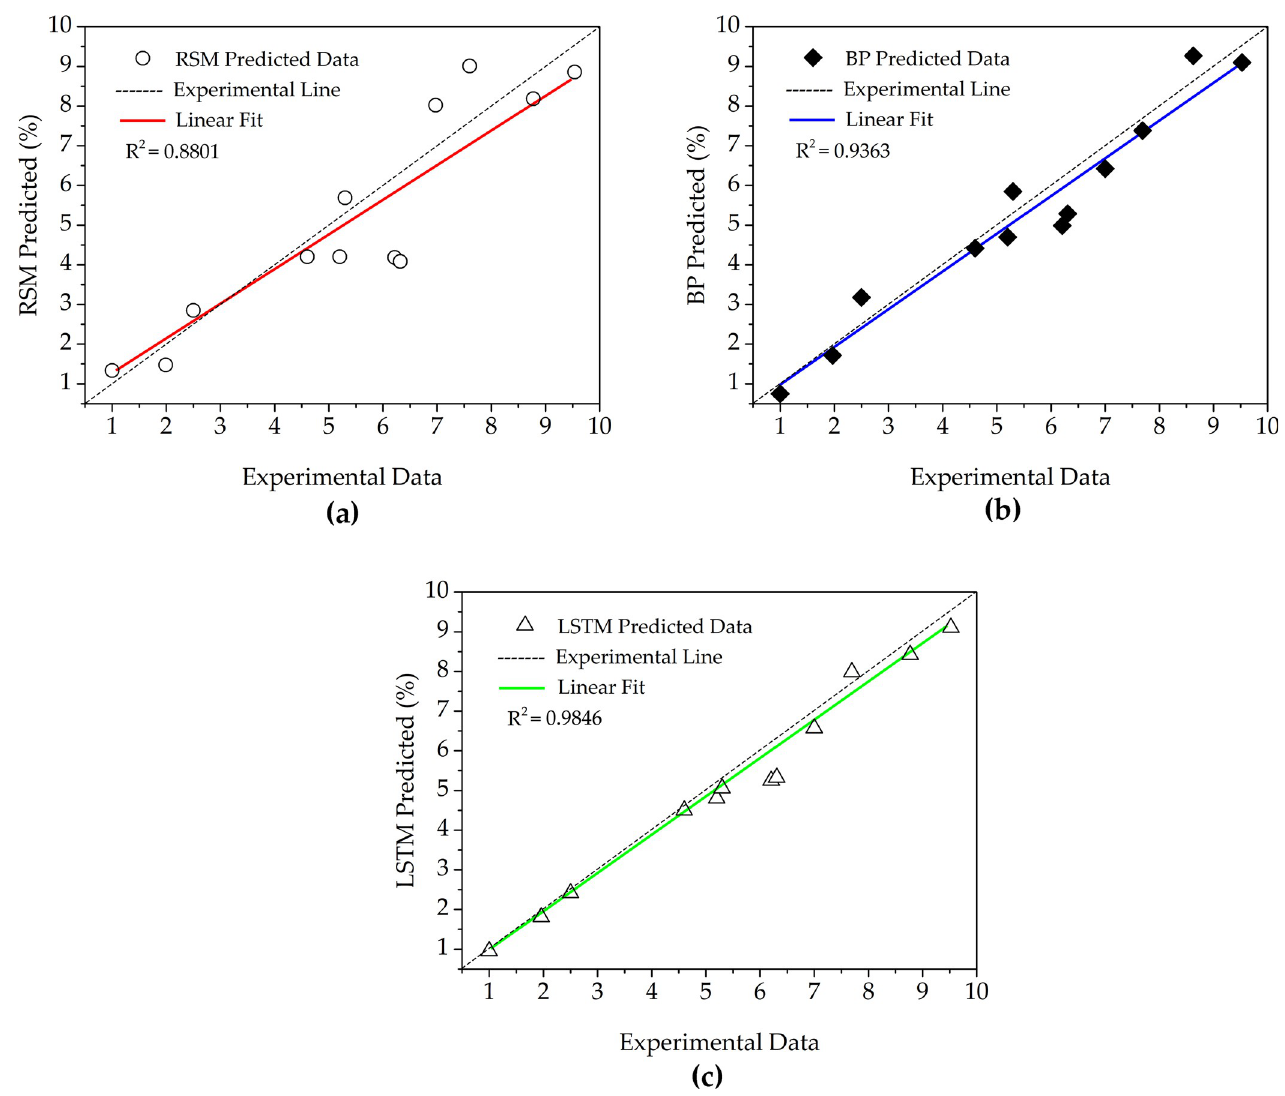
Fig 14. Comparative analysis on experimental predicted values of three models, (a) RSM model, (b) BP model, (c) LSTM Model.